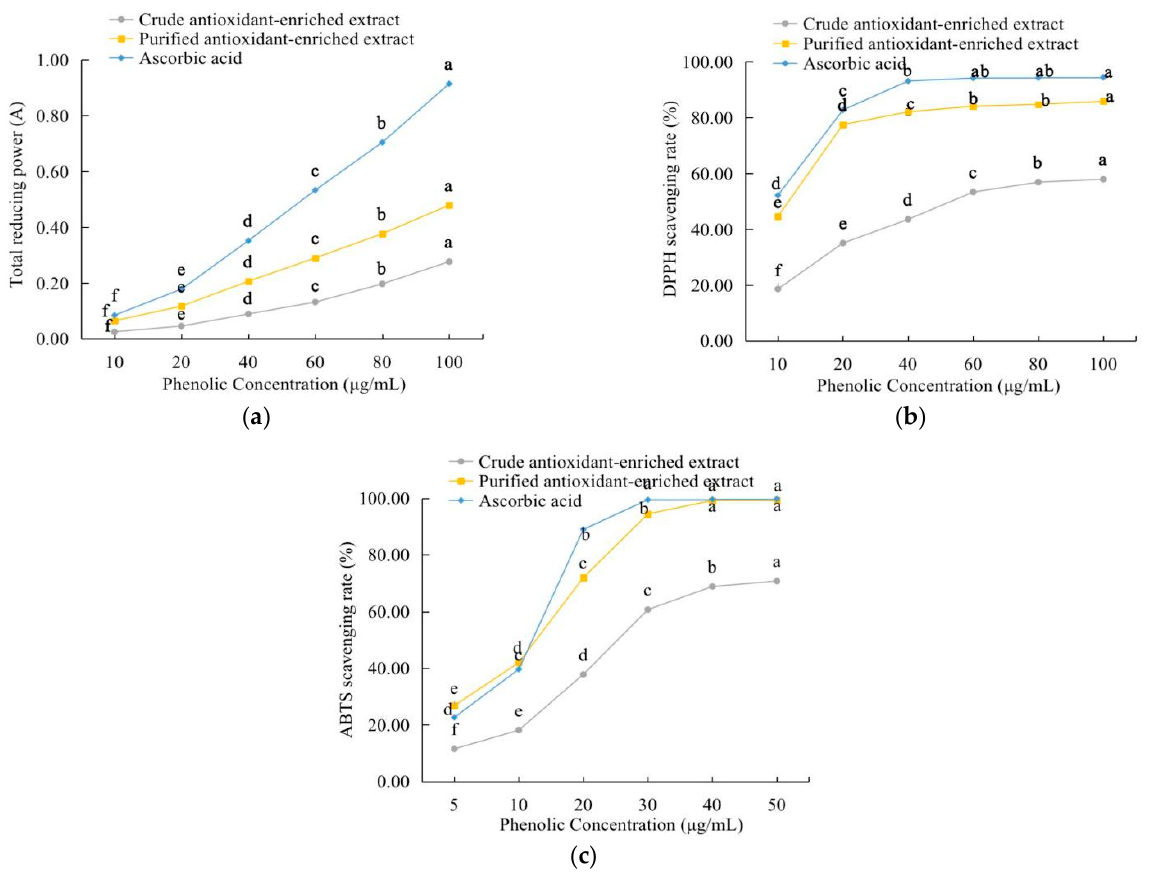
Figure 4. Antioxidant capacities of the C. speciosa antioxidant-enriched extract: ( a ) the total reducing power; ( b ) DPPH radical-scavenging activity; ( c ) ABTS radical-scavenging activity. Different letters indicate significant differences ( p < 0.05)